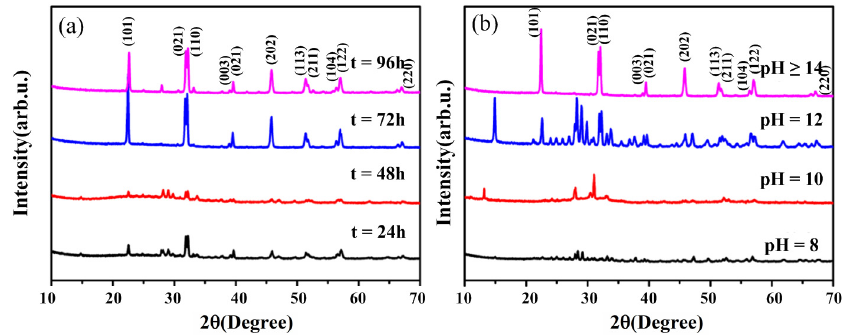
Figure 1. X-ray diffraction patterns of different ( a ) hydrothermal times and ( b ) precursor pH values.